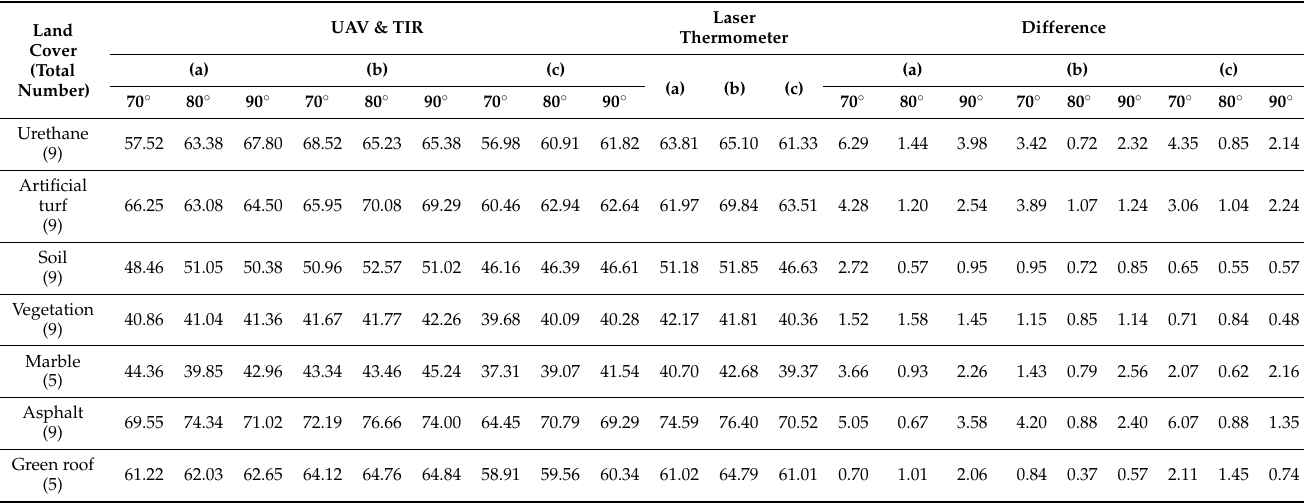
Table 5. Average LST difference of site B by land cover (unit: ◦ C): ( a ) 29 July 2021, ( b ) 5 August 2021, ( c ) 17 August